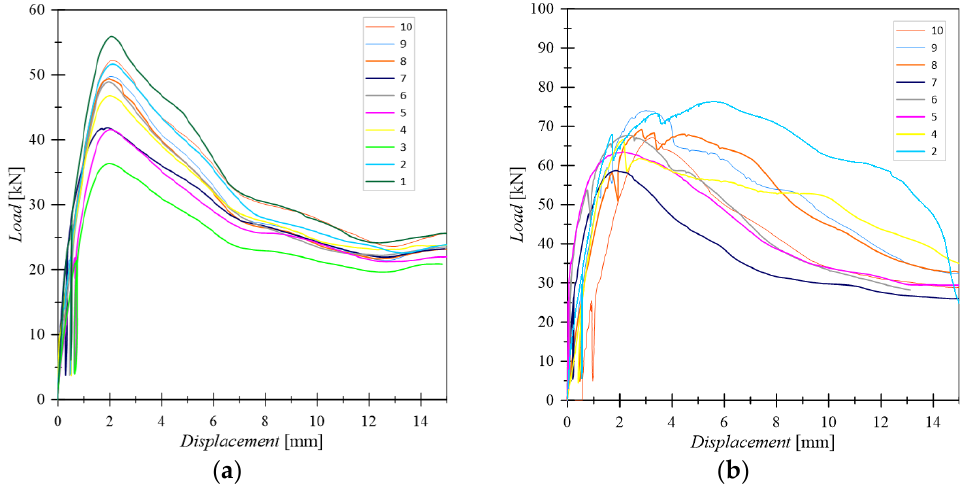
Table 1. Specimen geometric data, FE numerical results per screw and corresponding percentage scatters.